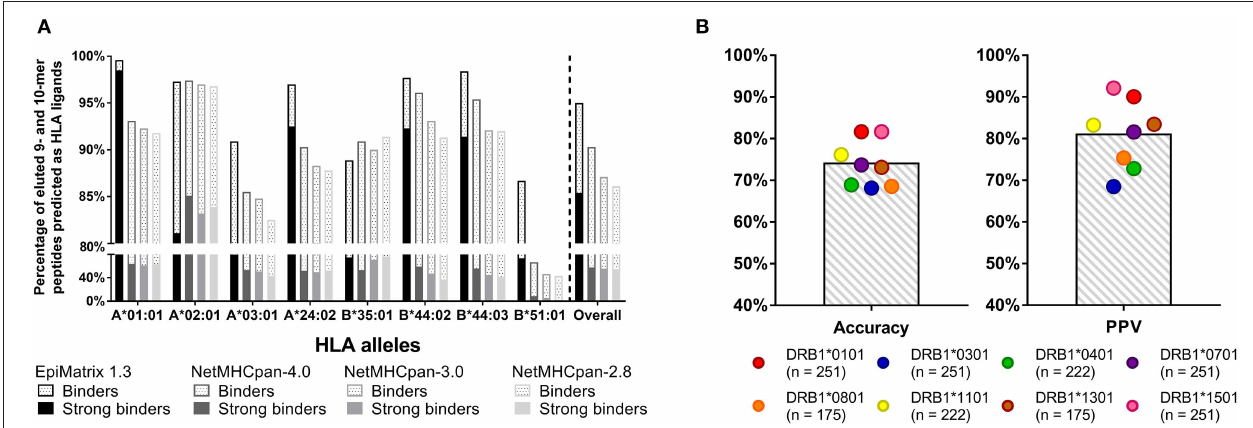
FIGURE 3 | Recent validation studies: (A) CD8T cell epitopes. Retrospective analysis of eluted peptide dataset published by Abelin et al. (23) 95% of eluted 9- and 10-mers are predicted to bind to HLA according to EpiMatrix, many of which are predicted strong binders (solid bars). Only ∼ 88% of ligands were accurately recalled by various versions of NetMHCpan. EpiMatrix also identifies the majority of the eluted ligands as high affinity binders (85% of all eluted peptides, solid bars), whereas only up to 58% of ligands were identified as high affinity binders (IC50 ≤ 50nM) by NetMHCpan. (B) CD4T cell epitopes. Prospectively validation of EpiMatrix selections in in vitro HLA binding assays: EpiMatrix HLA class II predictions are 74% accurate when tested in in vitro HLA binding assays, with an average observed Positive Predictive Value (PPV) of 81%. The number of peptides tested for each HLA allele is shown in parenthesis. Selected peptides were published in reference 23 and some are